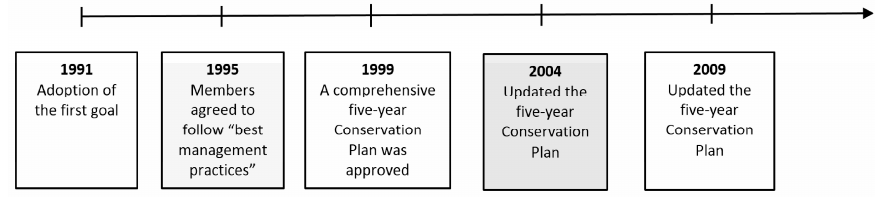
Figure 3. Timeline of conservation adoption goal and comprehensive plan for Las Vegas.